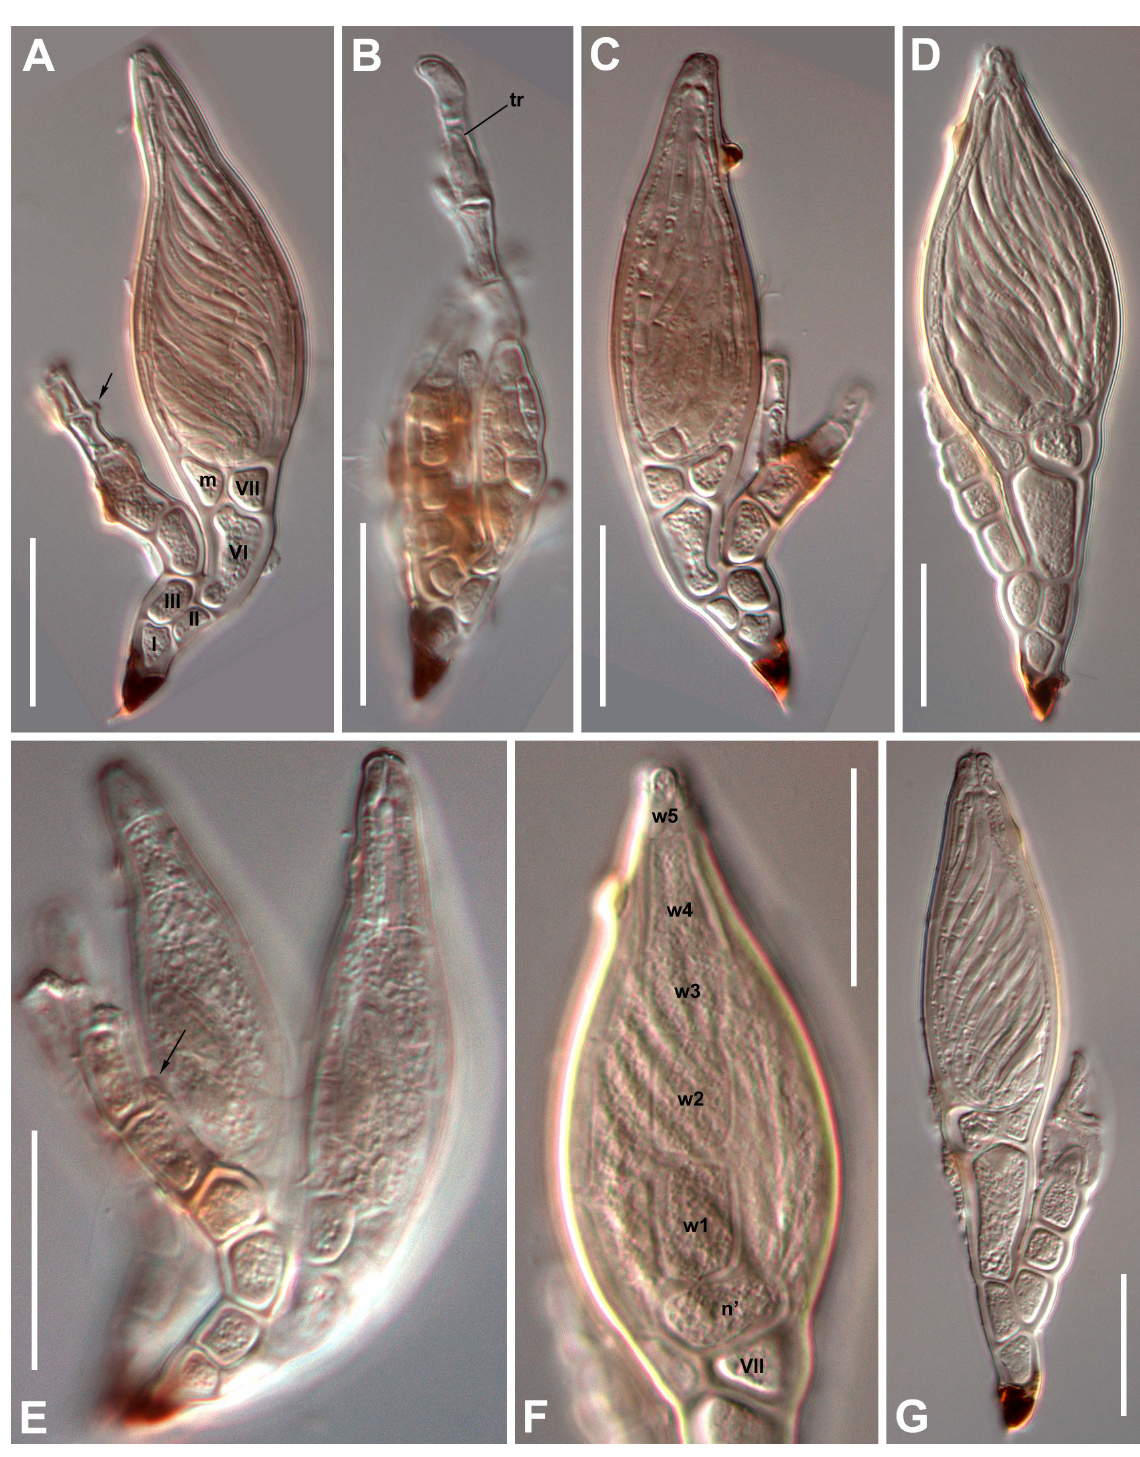
Fig. 48. Cryptandromyces bibloplecti T.Majewski. A . Mature thallus showing probable efferent necks of antheridia (arrow) and labelling of some thallial cells (I, II, III, VI, VII, and m). B . Immature thallus showing trichogyne (tr). C – D , G . Mature thalli. E . Paired mature thalli showing probably efferent neck of an antheridium (arrow). F . Perithecium in detail with labelling of cells VII, n’, and w Bibloplectus ambiguus . D , F – G . From Tychus niger . Scale bars: 20 µm. Photographs from slides ZMUC C-F-123339 (A–C, E), ZMUC C-F-123827 (D,